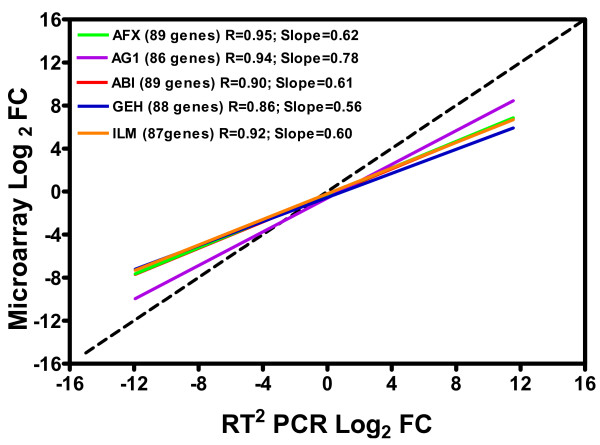
Cross-platform comparison between SYBR Green RT2 Profiler PCR Arrays and microarray platoforms. The concordance of fold-changes between the PCR Arrays and microarray platforms was evaluated by regression analysis of fold differences in sample B compared to sample A. Data were normalized against POLR2A for RT2 Profiler PCR Arrays. The sample B/sample A (B/A) fold changes (log2) for each gene common between RT2 Profiler PCR Arrays and another platform were subjected to bivariate analysis. The dashed line on the graph represents the ideal slope of 1.0. Each solid line represents the linear regression fit. The numbers in brackets indicate the number of common genes between RT2 Profiler PCR Arrays and each microarray platform. The individual scatter plot for each comparison is provided in Additional file 3.